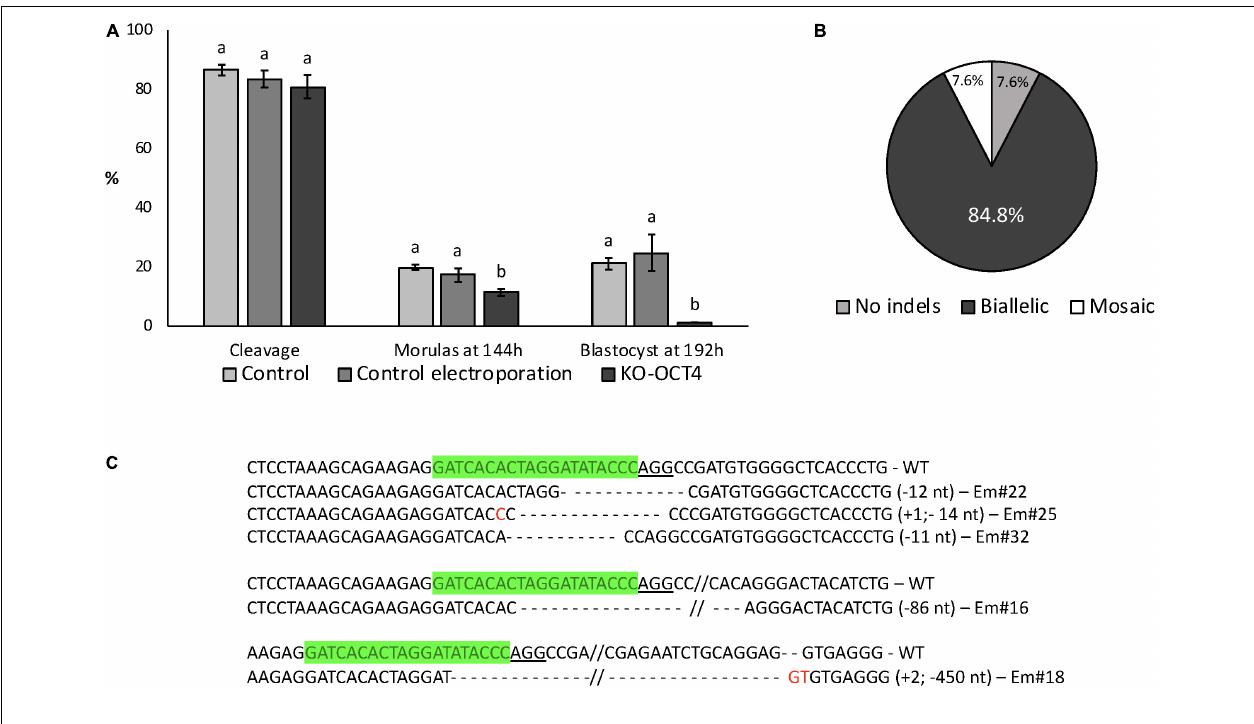
FIGURE 4 | Developmental capacity of zygotes electroporated with RNPs targeting OCT4 . (A) Embryo development until blastocyst stage. Control: no electroporation; Control electroporation: electroporation with RNPs targeting SCD1 ; KO-OCT4: electroporation with RNPs targeting OCT4 . a , b Different letters within developmental stage indicate statistically significant differences ( P < 0.05). Sample size for cleavage and morulas at 144 h (five replicates): control = 167; control electroporation = 117; and KO-OCT4 = 220. Sample size for blastocyst (three replicates): control = 81; control electroporation = 55; and KO-OCT4 = 87.